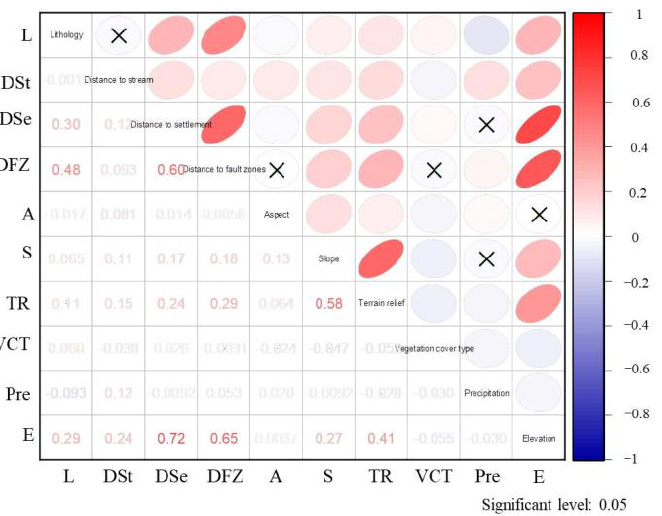
Figure 6. Elliptical diagram of Pearson correlation of LCFs . L—lithology; DSt—distance to stream; DSe—distance to settlement; DFZ—distance to fault zones; A—aspect; S—slope; TR—terrain relief; VCT—vegetation cover type; Pre—precipitation;